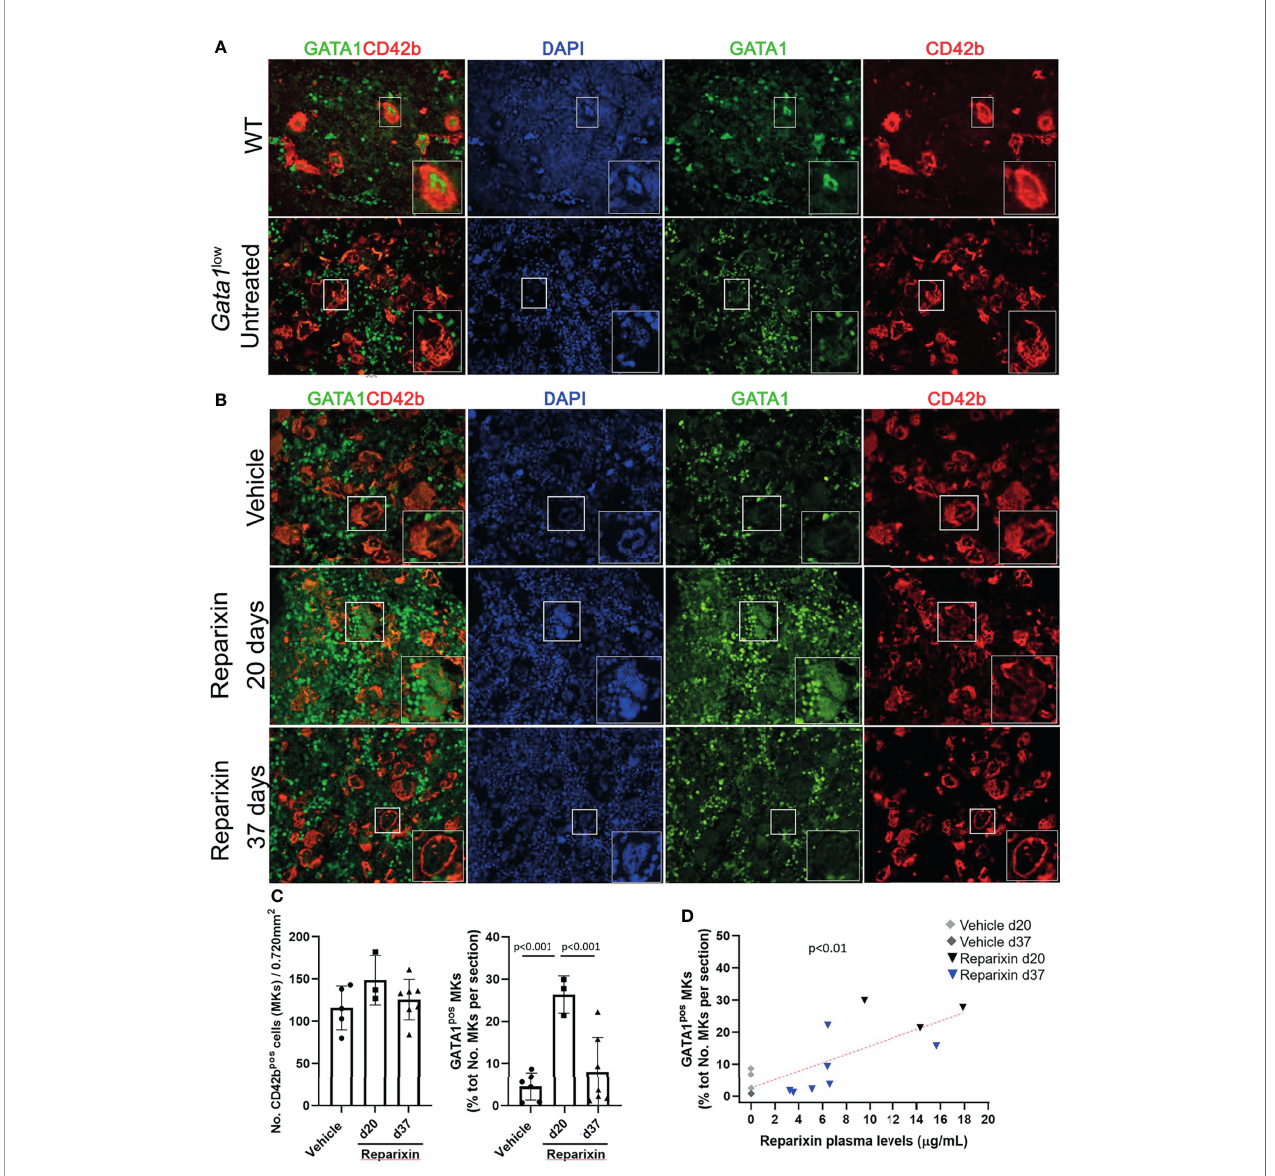
FIGURE 7 | Reparixin restores in a concentration-dependent fashion the GATA1 content of the MKs in the BM of Gata1 low mice. (A) Double immuno fl uorescence staining with GATA1 (FITCH-green) and CD42b (TRITCH-red), as a marker of MKs (45), antibodies of BM sections from representative wild-type (WT) and untreated Gata1 low mice, as indicated. The hypomorphic Gata1 low mutation selectively reduces expression of GATA1 in the MKs from the BM of Gata1 low mice compared to the correspondent cells from WT littermates. Magni fi cation ×400. (B) Double immuno fl uorescence staining with GATA1 (FITCH-green) and CD42b (TRITCH-red) of BM sections from representative mice treated either with vehicle or Reparixin for 20 or 37 days, as indicated. Magni fi cation ×400. The boxes in (A) and (B) _ indicate the MKs shown at greater magni fi cation on the bottom of the panels. (C) Frequency of MKs and percentage of MKs positive for GATA1 in BM sections from multiple treated mice. Data are presented as Mean (± SD) and as values in individual mice (each symbol a mouse). Results were analyzed by Tukey ’ s multiple comparisons test. P < 0.05 were considered statistically signi fi cant. (D) Correlation between the percent of MKs positive for GATA1and plasma levels of the Reparixin in individual mice (Pearson R = 0.76, p < 0.01). Each dot represents a single